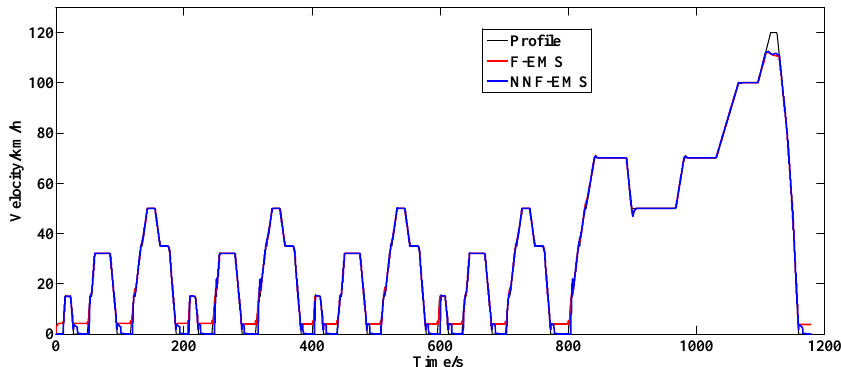
Figure 15. Vehicle velocity following under NEDC cycle.